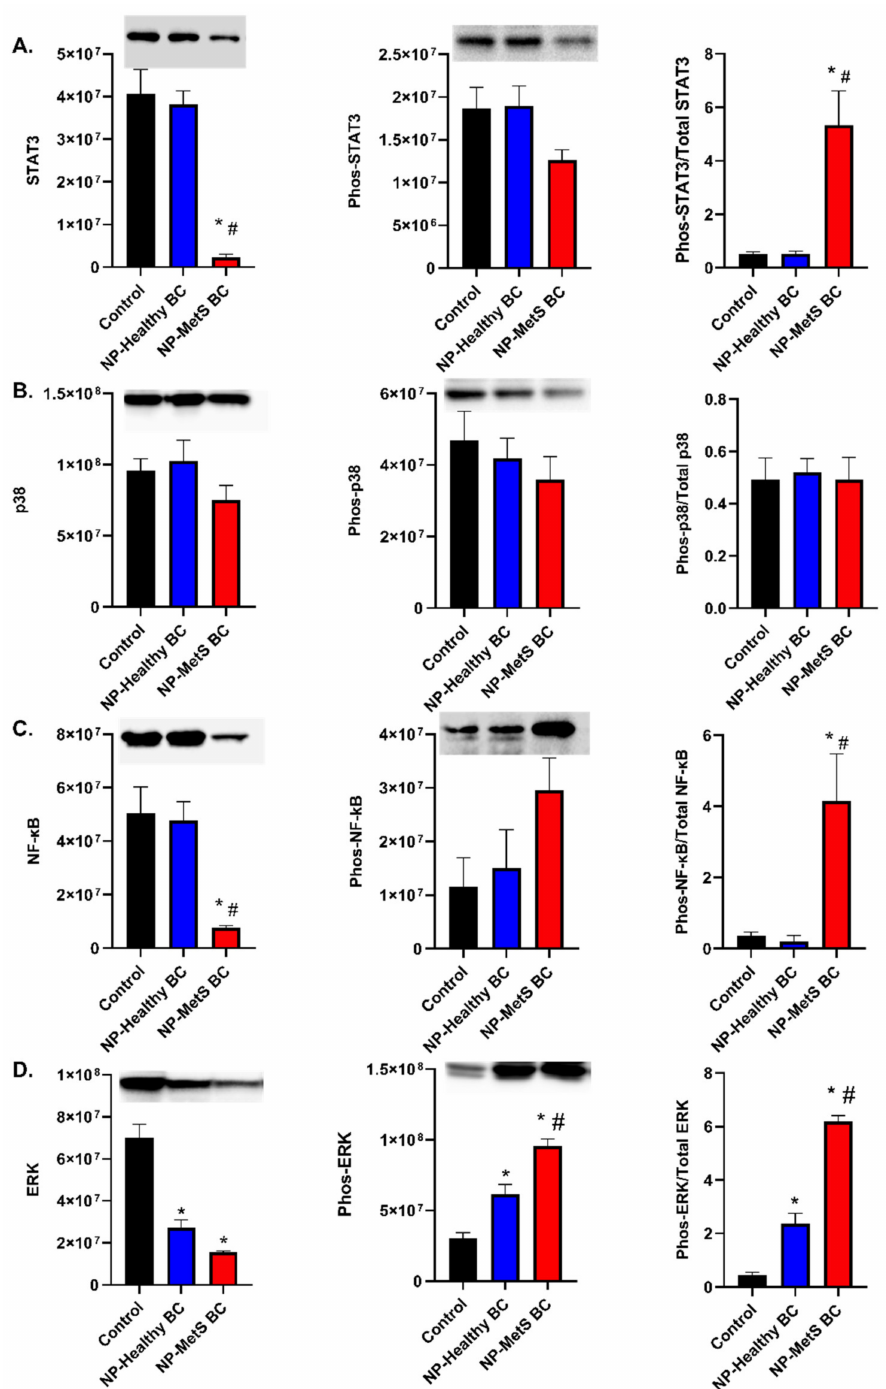
Figure 9. Inflammatory signaling after a 1 h exposure to NPs with MetS or healthy BCs. Changes in protein level following exposure to Fe 3 O 4 NPs with a healthy or MetS BC. Cells were exposed to 25 µ g/mL of Fe 3 O 4 NPs with BCs for 1 h (n = 3/group). Activation of STAT3 ( A ), P38 ( B ), NF- κ B ( C ), and ERK ( D ) pathways were assessed through Western blot to evaluate MetS-related inflammatory signaling pathways following NPs exposures. * Denotes statistical significance compared to the expression of control group, # denotes statistical significance compared to the Fe 3 O 4 NPs with a healthy BC ( p < 0.05). Quantification of each protein was normalized to the intensity of total protein (blots found in Supplementary Materials Figure